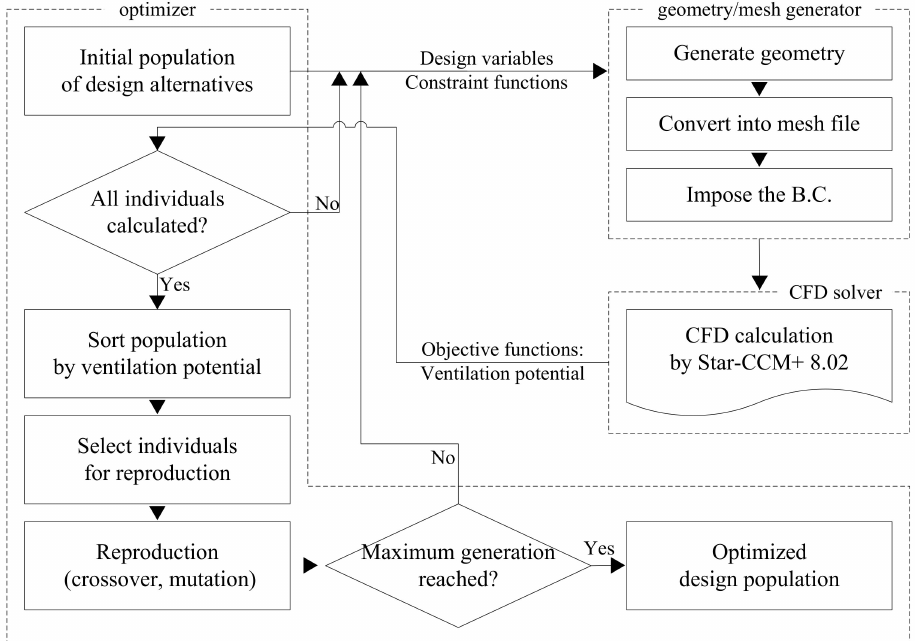
Figure 2. Flowchart for the proposed design method.